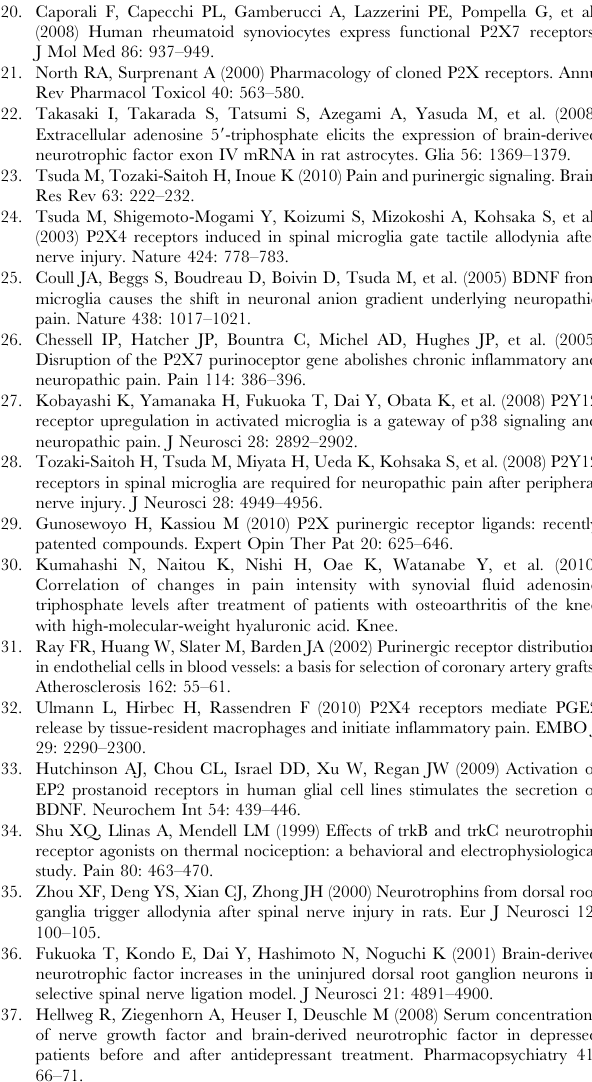
Figure S2 Cyclooxygenase (COX) is not involved in the ATP-induced regulation of BDNF expression. OASF (n= 6) were stimulated with the COX inhibitor sc-560 (100 nM) and ATP (100 m M) for 2 h. The ATP-mediated increase in BDNF expression was not changed by COX-inhibitor treatment. Data are shown as means 6 standard deviations. N.s., not significant; *, p , 0.05, **, p ,